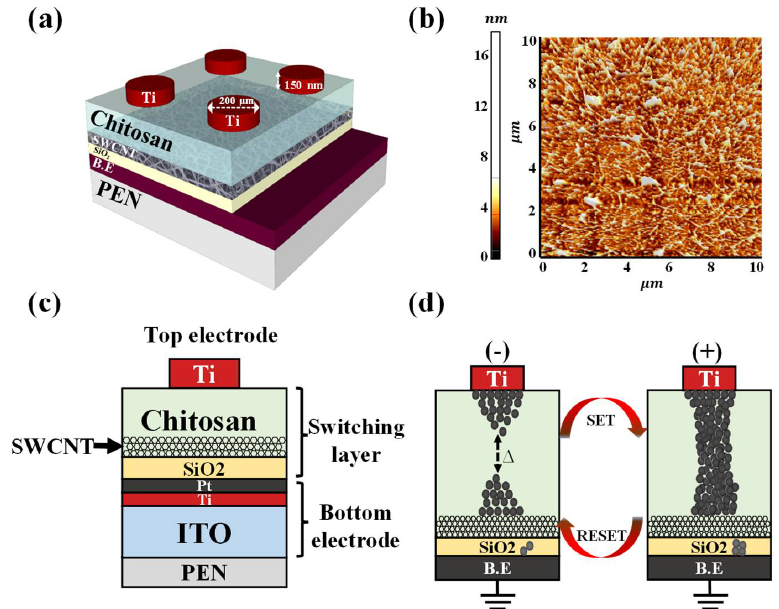
Figure 1. Overview of the developed memristors. ( a ) Schematic diagram of chitosan–SWCNT nanocomposite memristors. ( b ) atomic force microscopy (AFM) image of the single-walled carbon nanotube (SWCNT) random network (10 µ m × 10 µ m). ( c ) Cross-sectional view of the chitosan– SWCNT nanocomposite memristors. ( d ) Simplified mechanism of filament formation and